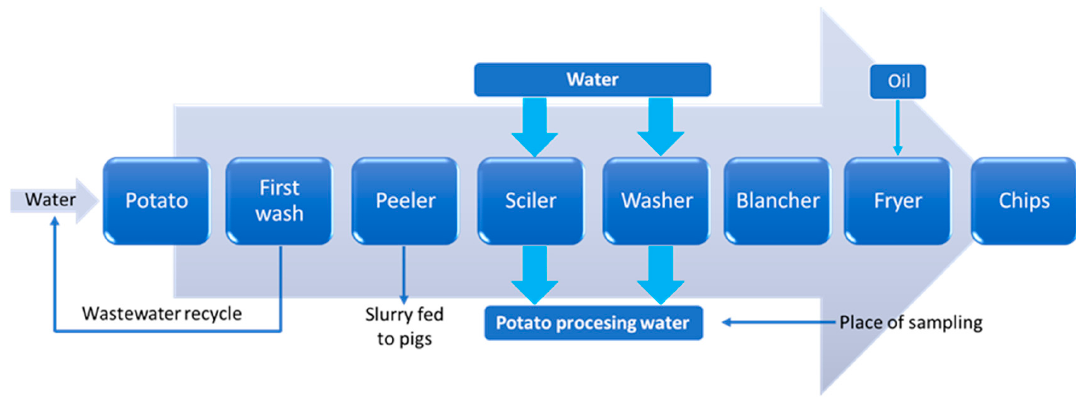
Figure 2. Block diagram of potato chip production and processing water.